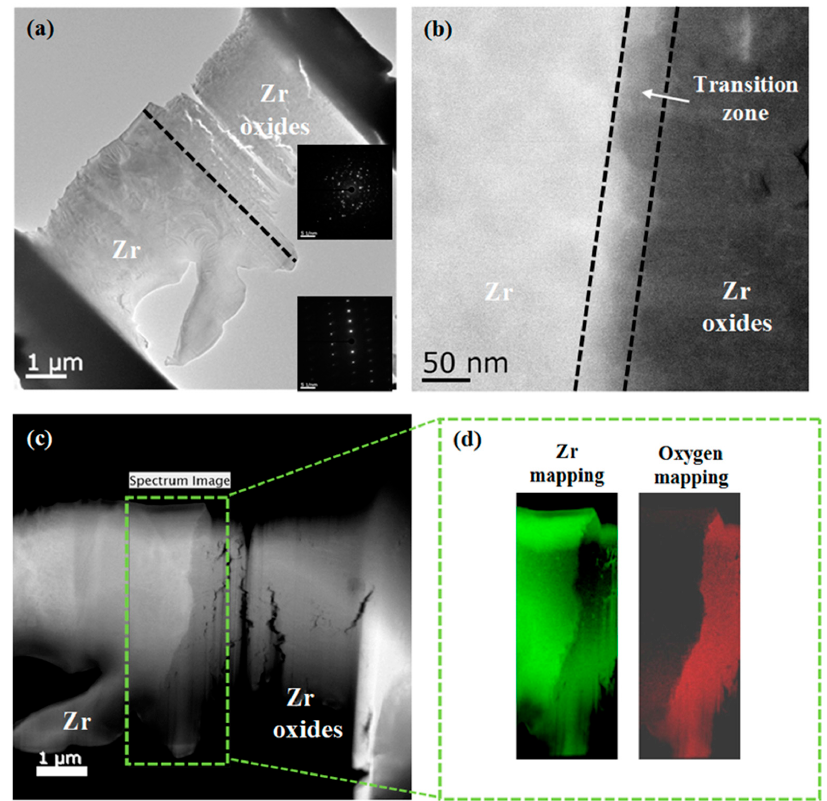
Figure 8. TEM micrographs of cross sections of the Zicroly-4 specimen with 350 ppm of hydrogen after oxidation at 650 °C for 25 h. ( a ) TEM image of the Zr substrate and oxides layers. The upper and lower inserts display the selected area electron diffraction (SEAD) patterns of the Zr oxides and substrate, respectively. ( b ) Bright-field image for examining the boundary between the Zr substrate and Zr oxides, ( c ) Scanning transmission electron microscopy (STEM) image used for EELS analysis, and ( d ) EELS mapping of Zr and O.